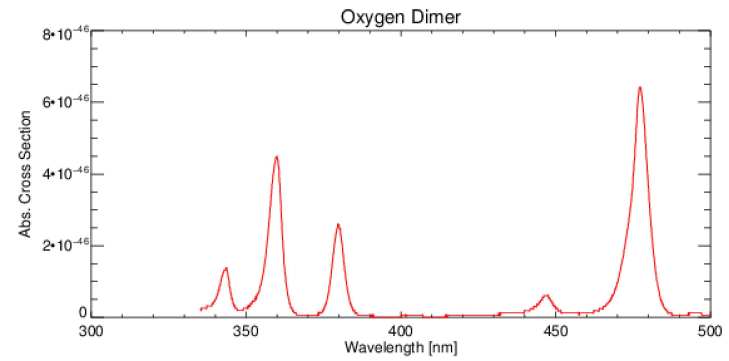
Figure 1. Absorption cross-sections of the oxygen dimer at 293 K determined from